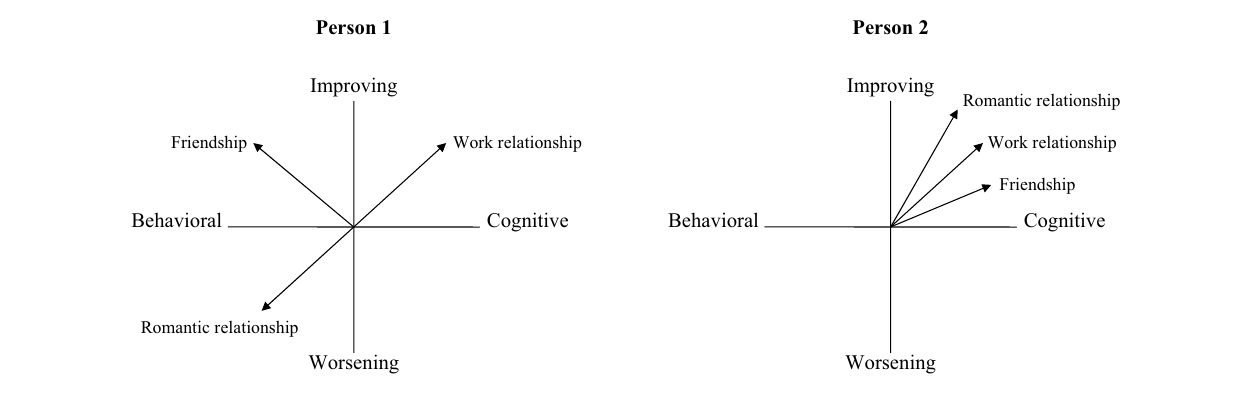
FIGURE 1 | Illustration of a person with high spin (left panel) and low spin (right